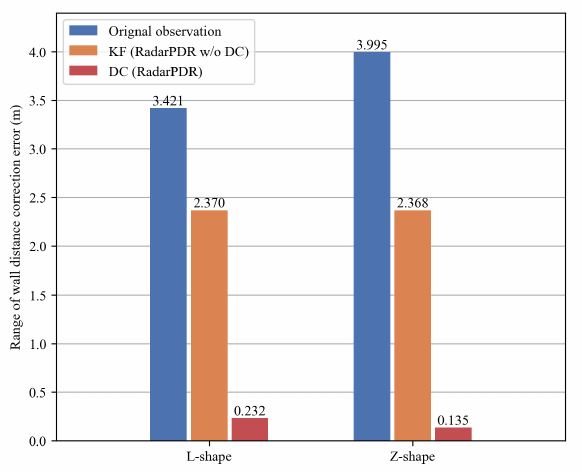
Figure 10. Wall distance error range of all the testing trajectories on the L-shape and the Z-shape